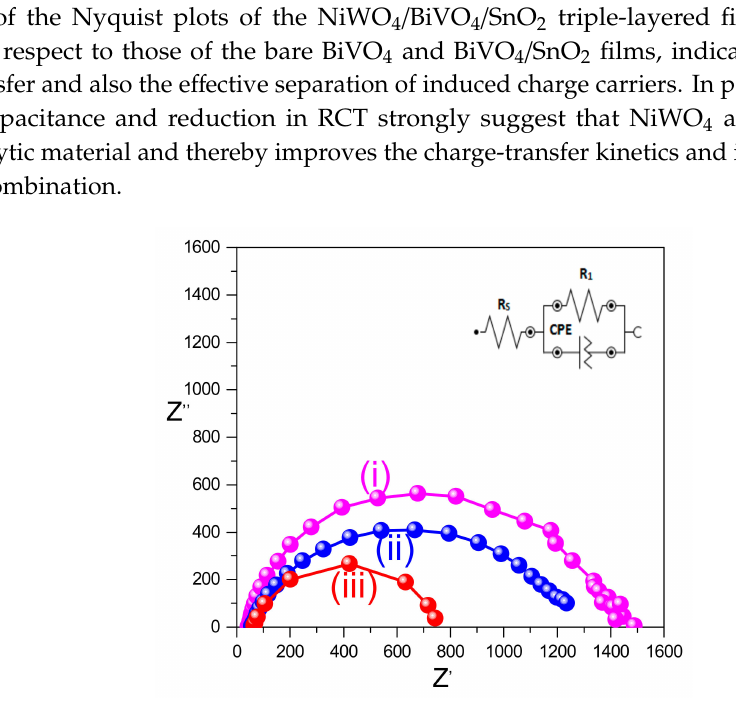
Figure 7. Impedance spectra investigation. Photoelectrochemical impedance spectroscopic (PEIS) of the ( i ) bare-BiVO 4 ( ii ) BiVO 4 / SnO 2 , and ( iii ) NiWO 4 / BiVO 4 / SnO 2 photoanodes. The PEIS analysis was performed at applied bias of 1.0 V RHE in the frequency ranging from 100,000 Hz to 0.05 Hz and the figure inset represents the corresponding circuit for the